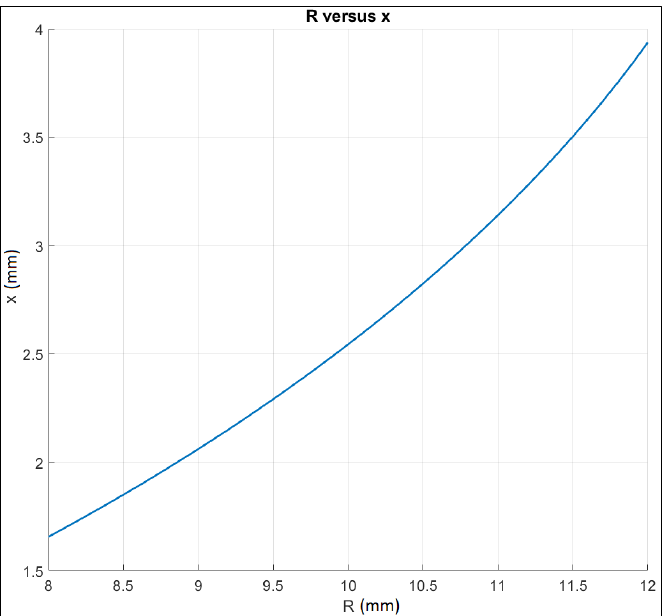
Figure 6. Shifting x versus disk radius R